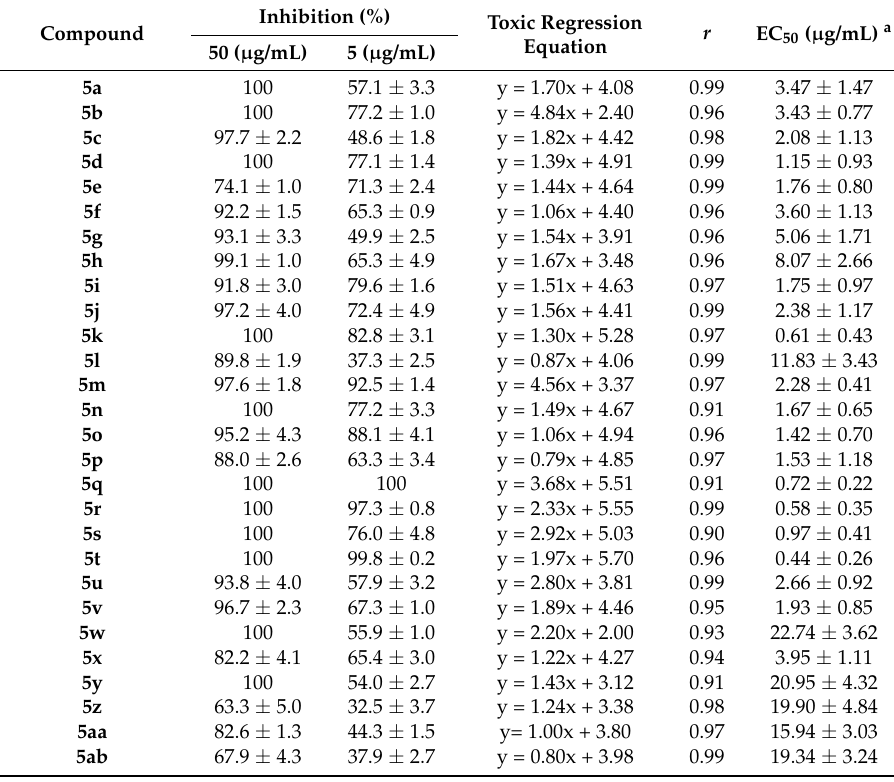
Table 1. Antibacterial activity of the target compounds against Xoo in